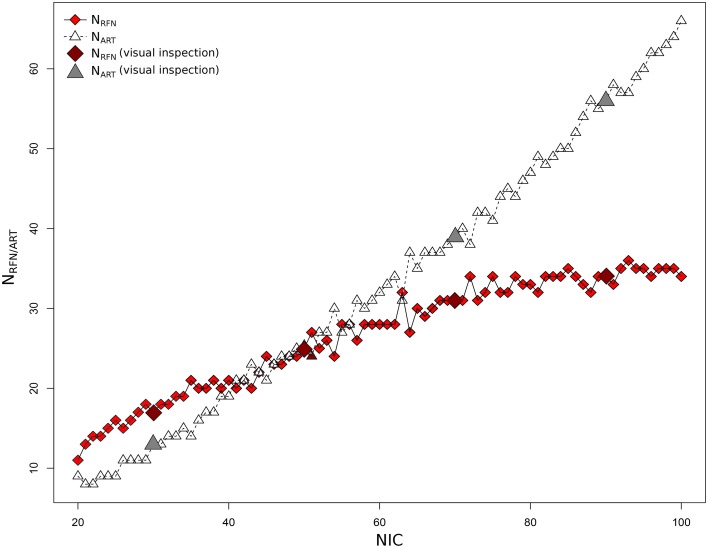
Number of RFNs and artifact components determined from automated and manual classifications as a function of NICfor dataset 1.